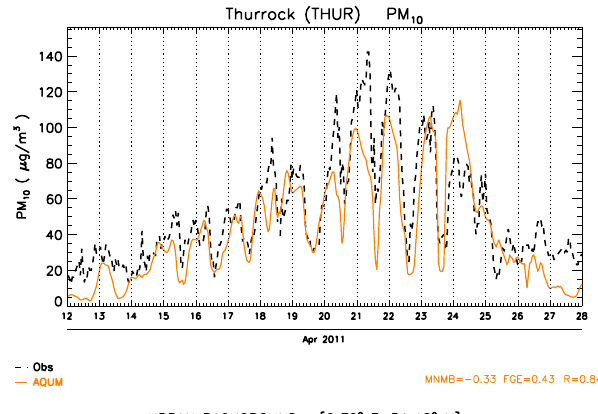
Fig. 11. Time series of hourly PM 10 concentrations (µgm − 3 ) for the urban background site of Thurrock, east of London at the peak of the April 2011 episode. Observed concentrations are shown as the black dashed line and the model output as the solid orange line.